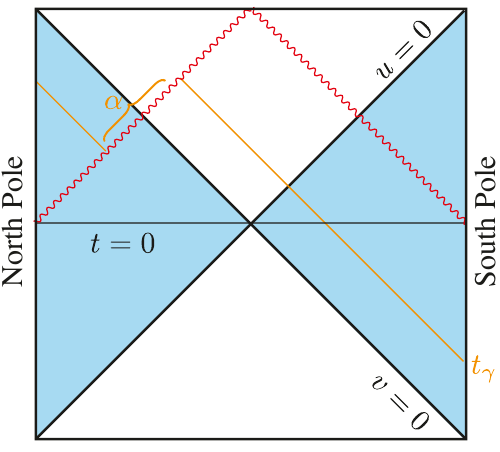
Figure 3 . A pair of shockwaves in de Sitter space and a shifted